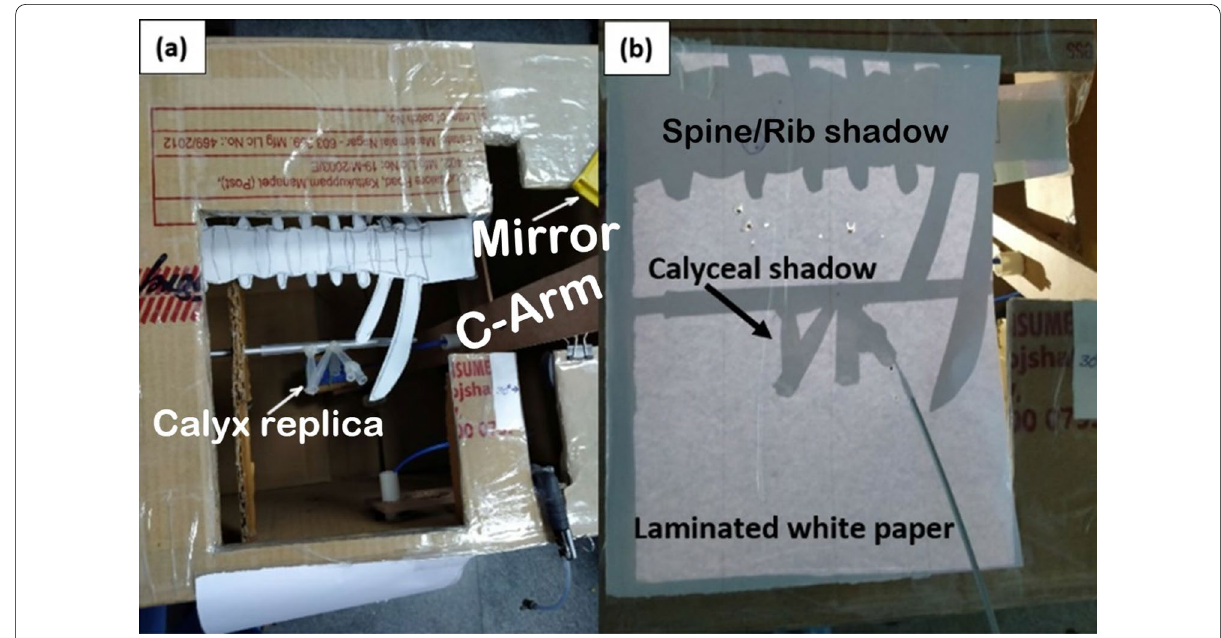
Fig. 2 a Replica of Calyx and Spine and b Calyx image captured on laminated white paper